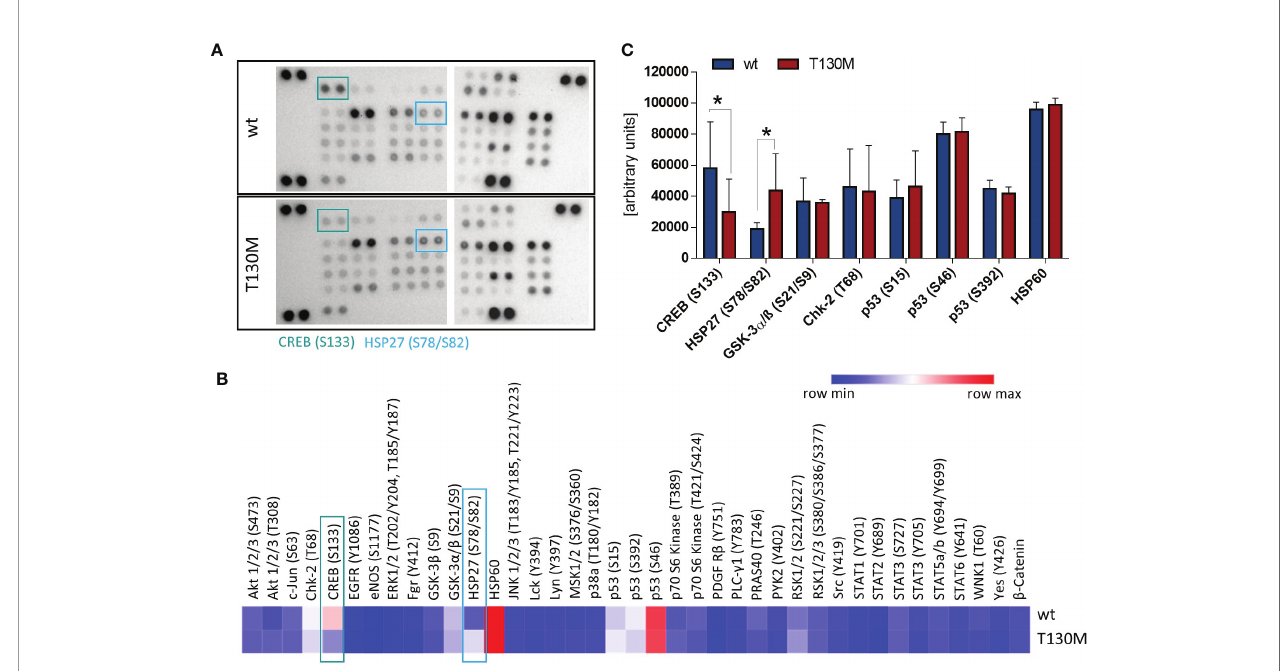
FIGURE 3 | P32-T130M reduces CREB phosphorylation and induces HSP27 activation. (A) Relative levels of phosphorylation of 37 kinase phosphorylation sites and two related proteins were determined with the Human Phospho-Kinase Array using whole cell lysates of stable HAP1 transfectants. Representative image from two experiments is shown. (B) Intensity of spots was analyzed densitometrically using ImageJ with the mean of both experiments displayed in a heatmap. (C) Comparison of phosphorylation levels of the most highly activated proteins CREB, HSP27, GSK-3 a / b , Chk-2, p53, and HSP60 between HAP1-p32-wt and HAP1- p32-T130M cells. S: Serine, T: Threonine, Y: Tyrosine. Statistical signi fi cance was calculated using a two-way ANOVA followed by Fisher ’ s LSD test. *p ≤